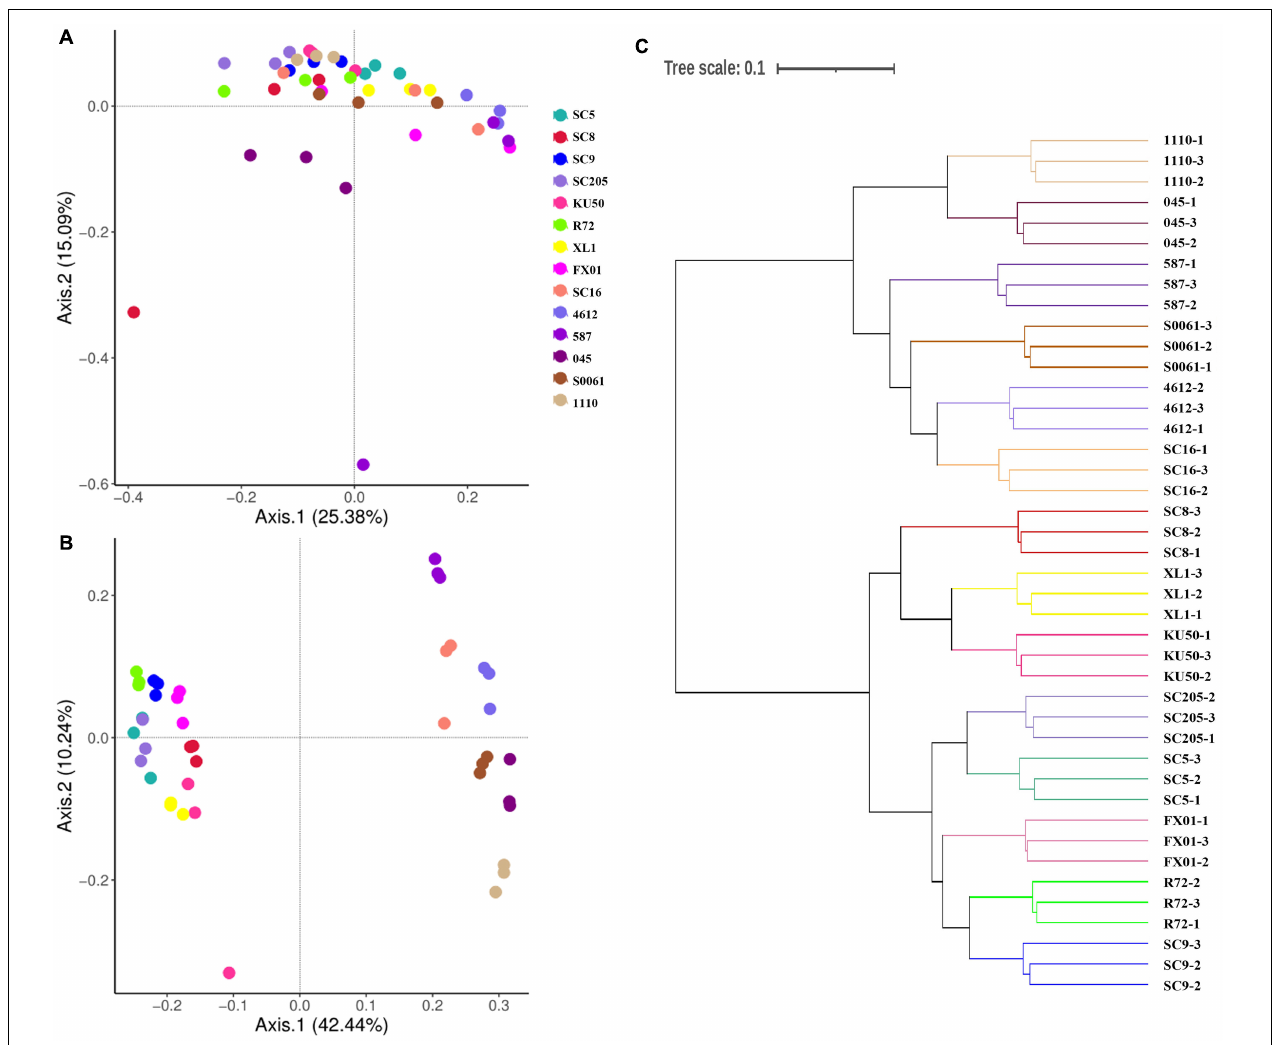
FIGURE 5 | Principal coordinates analyses (PCoA) were performed based on (A) tuber and (B) rhizosphere soil bacterial OTU distributions using Bray-Curtis distance. (C) Hierarchical cluster analysis (HCA) was used to form a cluster tree of rhizosphere soil bacterial communities of different cassava